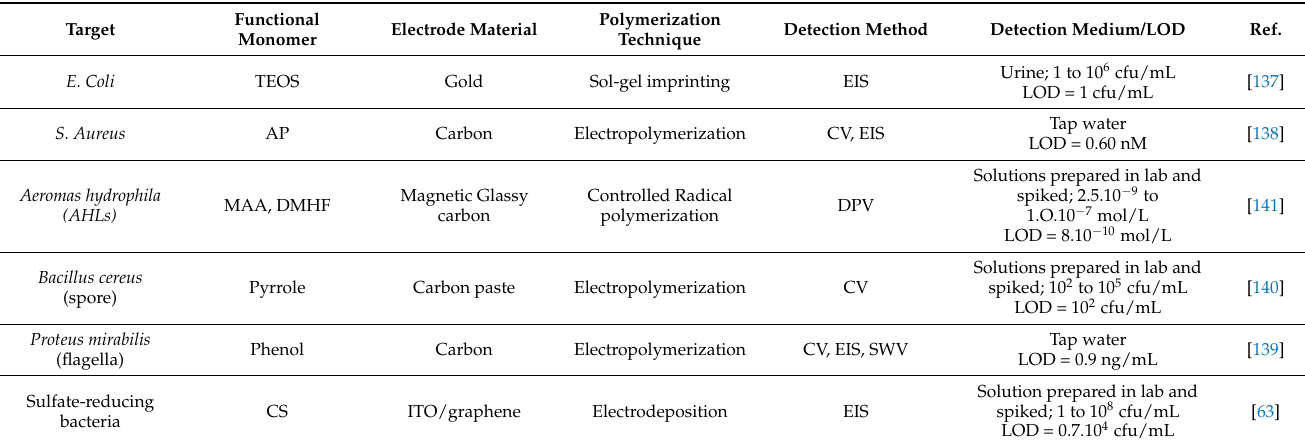
Table 6. Synoptic table reporting shortlisted MIP-based electrochemical sensors for the detection of a range of bacteria. The MIPs were prepared using bacteria or their specific molecular or macromolecular compounds.